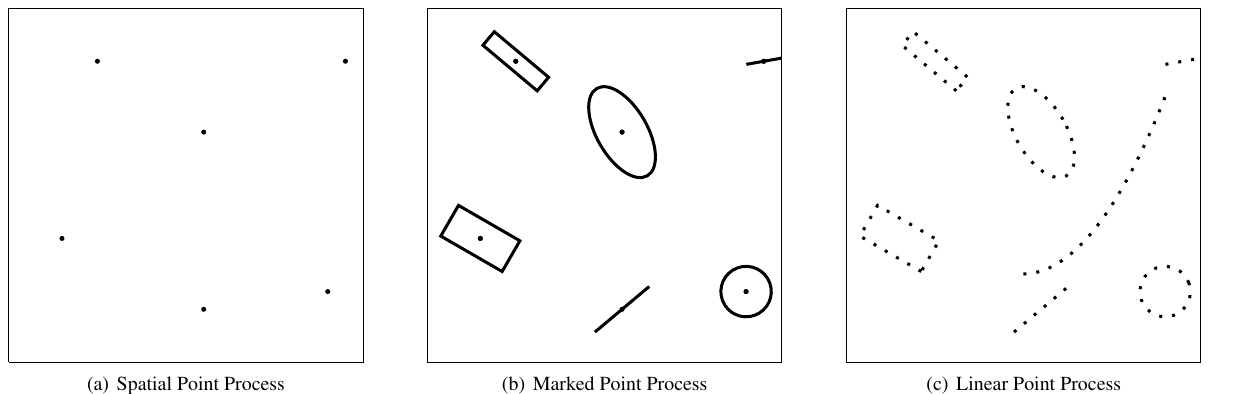
Figure 1: Overview of three kinds of spatial point